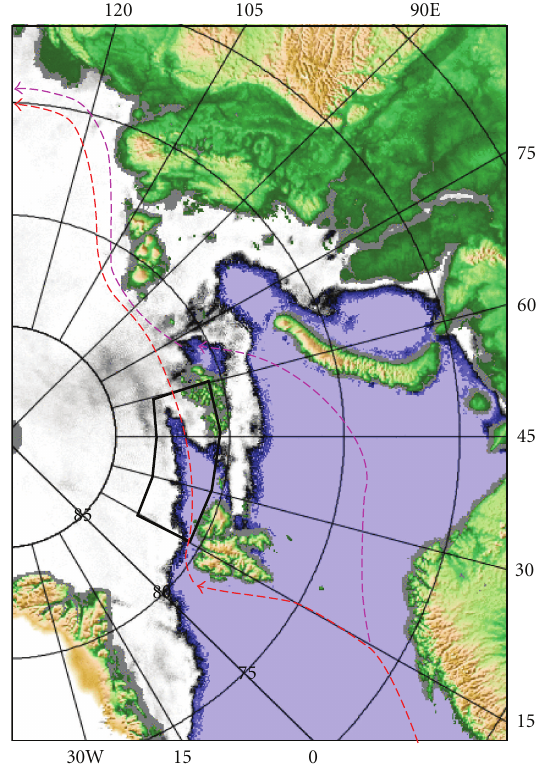
Figure 1: Schematic of two inflow branches (FSBW is shown in red and BSBW is shown in pink) of the AW against the special sensor microwave imager/Sounder (SSMIS) visual chart of ice concentration on February 4, 20112 (http://www.iup.uni- bremen.de:8084/ssmis/index.html). The Western Nansen Basin (WNB) area is marked by a black